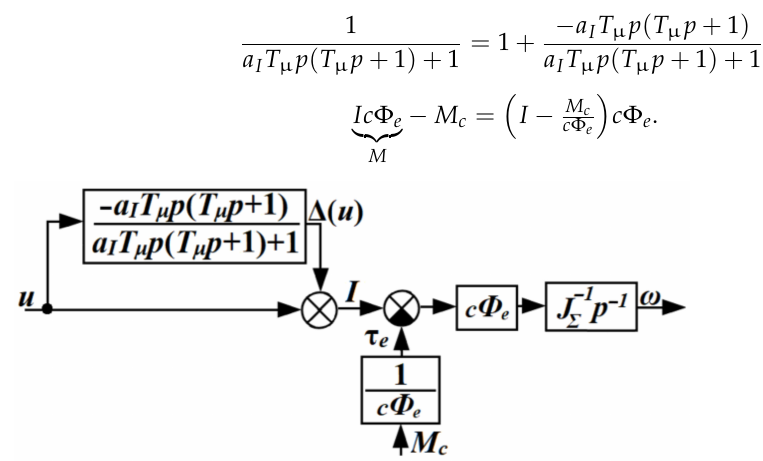
Figure 3. Transformed scheme of plant of DC drive speed control